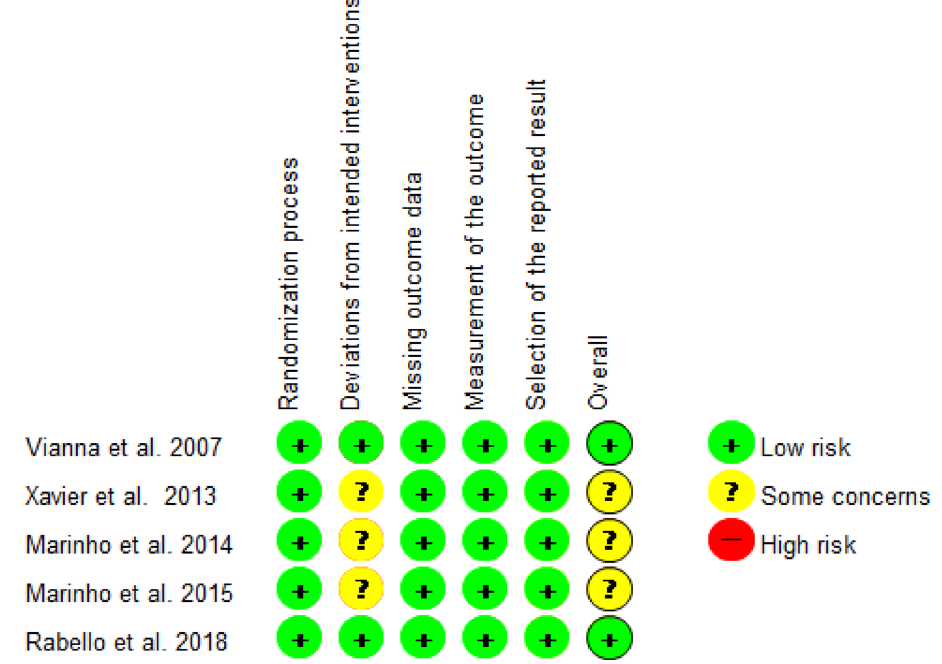
Figure 2. Bias risk assessment: summary of assessment according to the RoB2 tool.